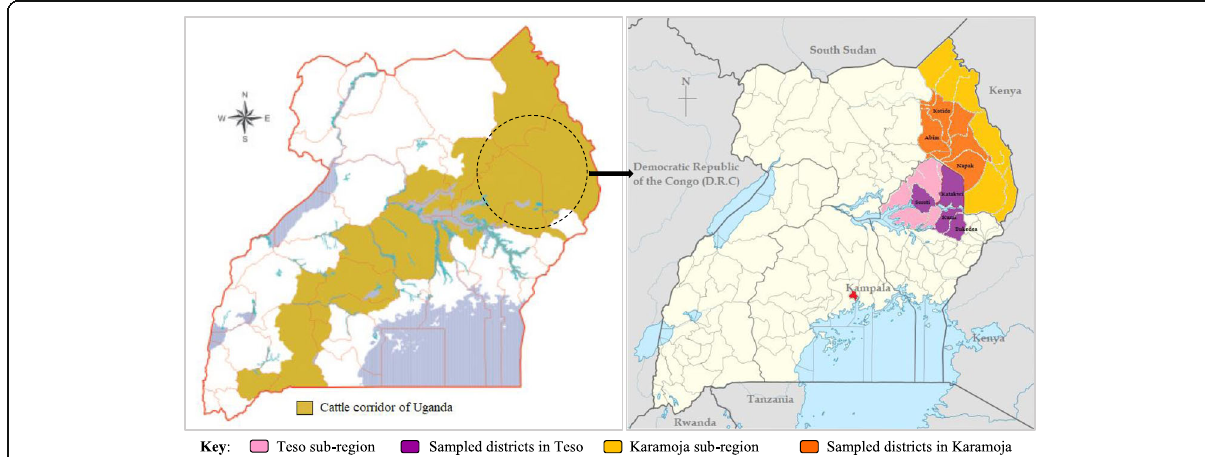
Fig. 3 Map of Uganda showing the study